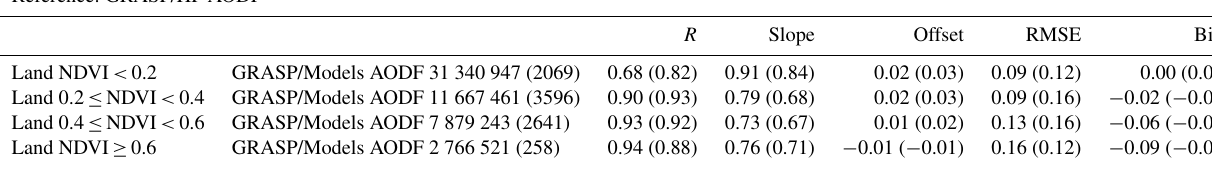
Table 22. Pixel-to-pixel statistical metrics between AODF products based on references of GRASP/HP over land pixels with four classes of surface (NDVI < 0.2, 0.2 ≤ NDVI < 0.4, 0.4 ≤ NDVI < 0.6 and NDVI ≥ 0.6); the statistics for only AERONET pixels are presented in brackets.